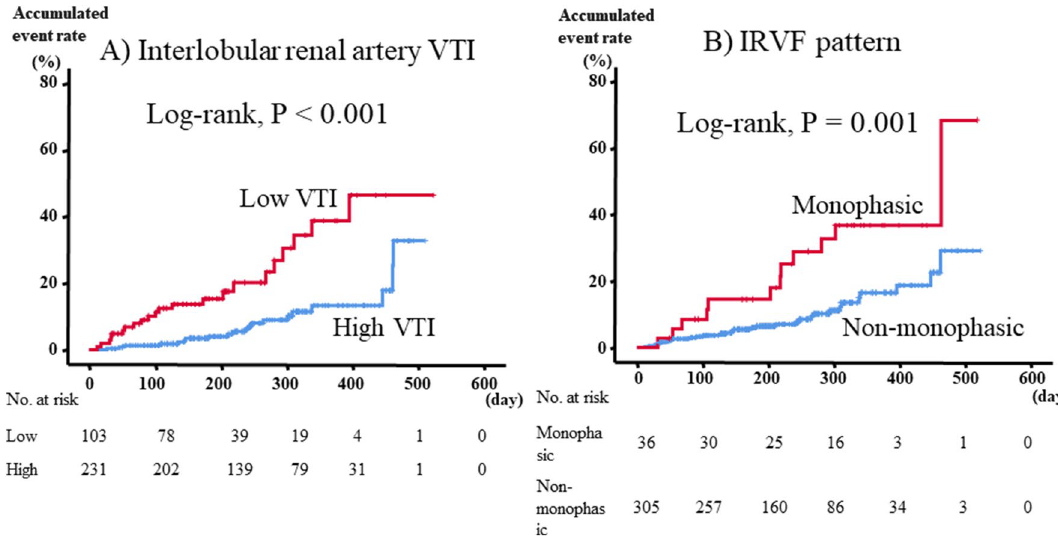
Figure 1. Kaplan–Meier analysis for cardiac events. VTI velocity time integral, IRVF intrarenal venous flow.